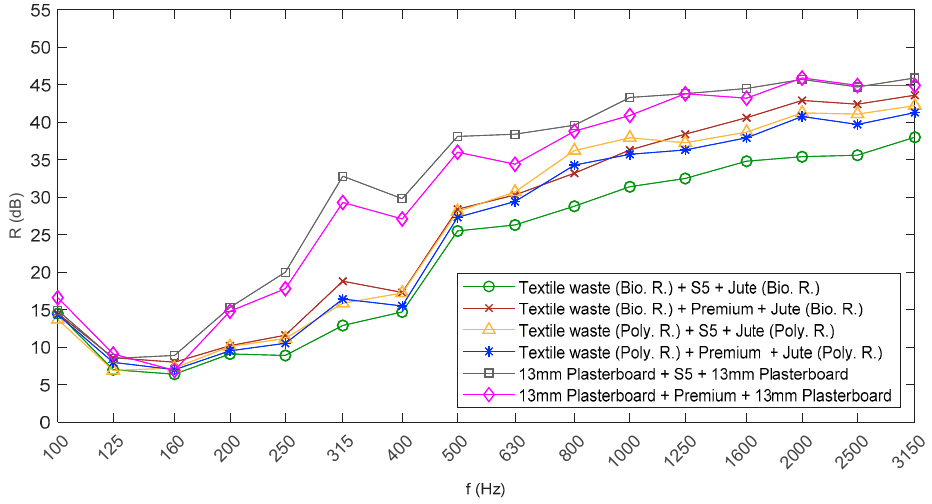
Figure 9. Sound reduction index of the proposed solutions measured in the reduced sized transmission chamber.